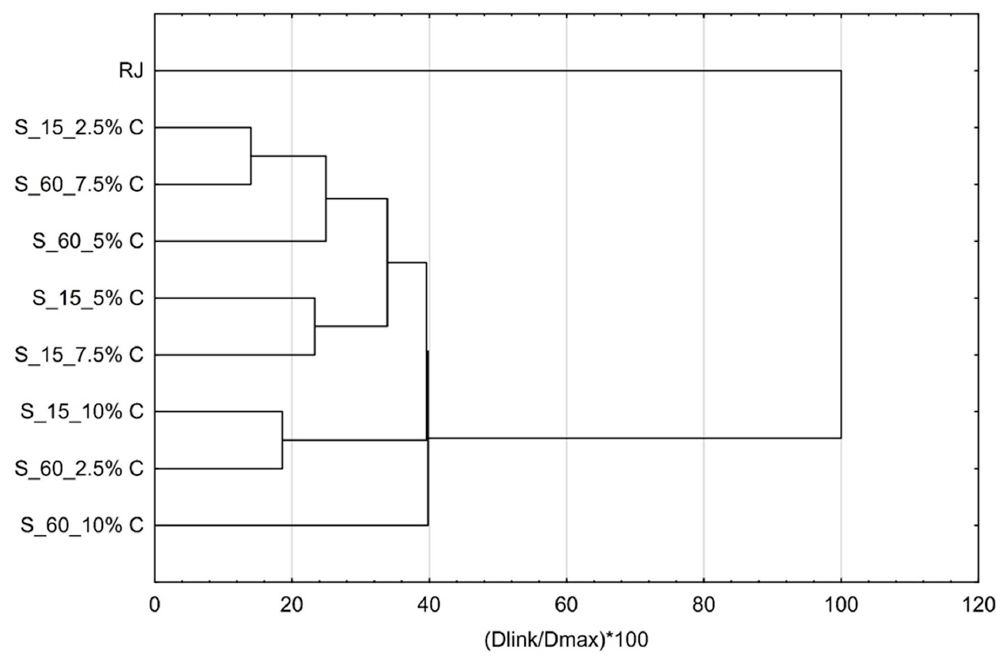
Figure 10. Cluster analysis of flavor profiles of cellulose/raspberry complexes after storage.